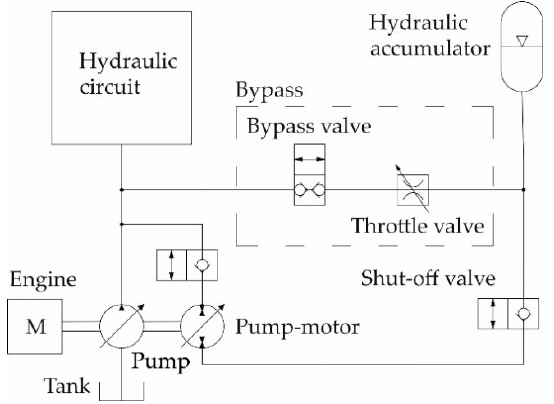
Figure 9. Hybrid solution with pump–motor.